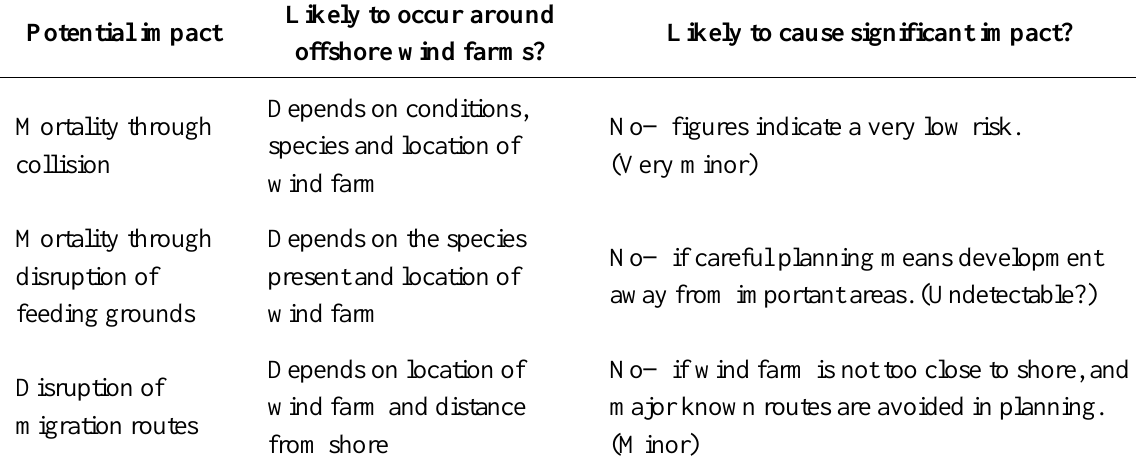
Table 5. Potential impacts of offshore wind farms: birds (modified from Wilson